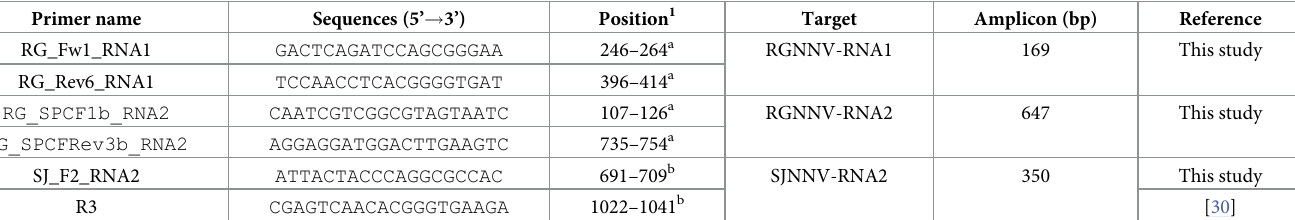
Table 1. Selected primer pairs for the multiplex one-step RT-PCR